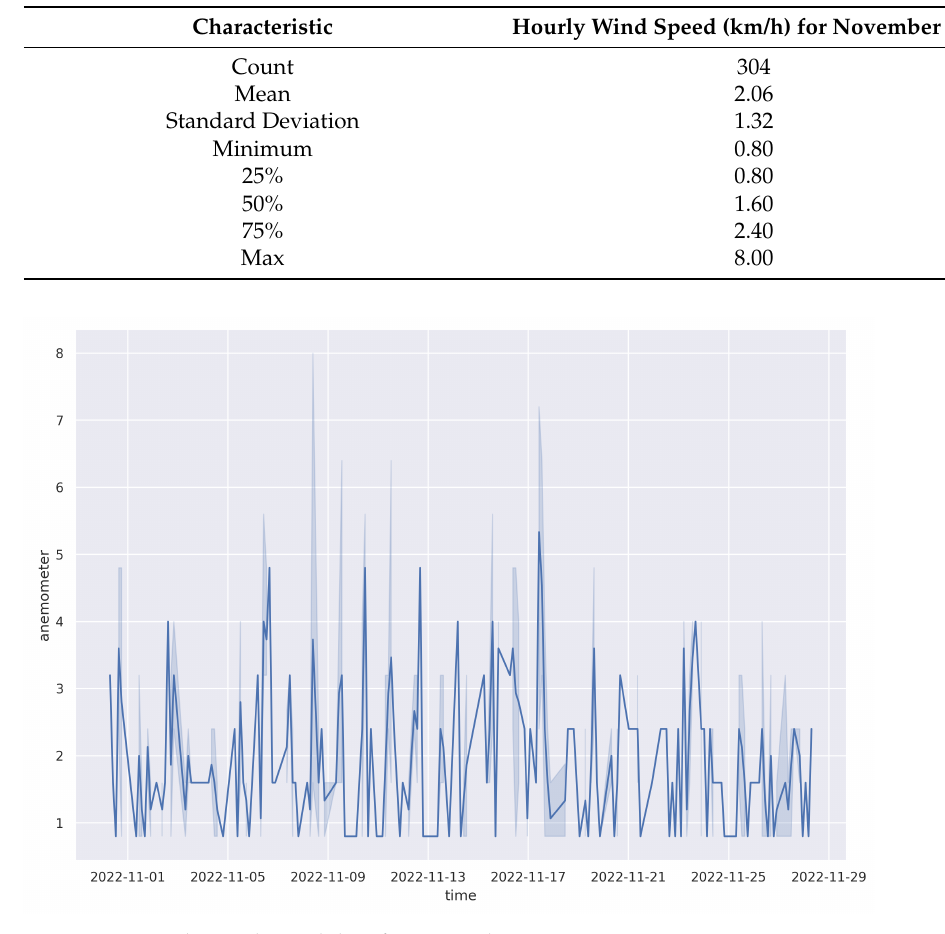
Figure 16. Hourly wind speed data for November 2022.